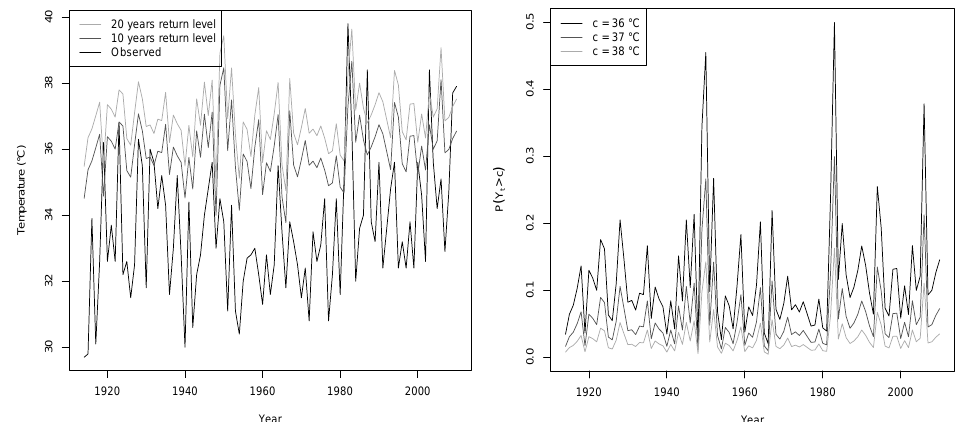
Figure 4. Left : posterior mean of 10 and 20 year return values by year. Right : posterior probability of the annual maximum temperature being higher than 36, 37, and 38 ◦ C by year according to the final GEV model. Barcelona